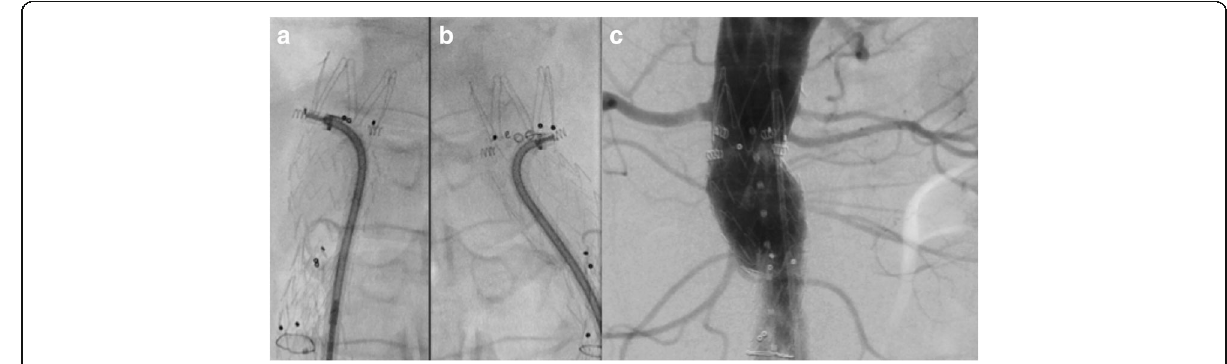
Fig. 2 Endoanchors were employed to fix the proximal graft given the short (< 10 mm) neck. a , b Fluoroscopic picture showing the delivery of the anchors. c Angiogram confirming the good apposition of the graft after the deployment of four